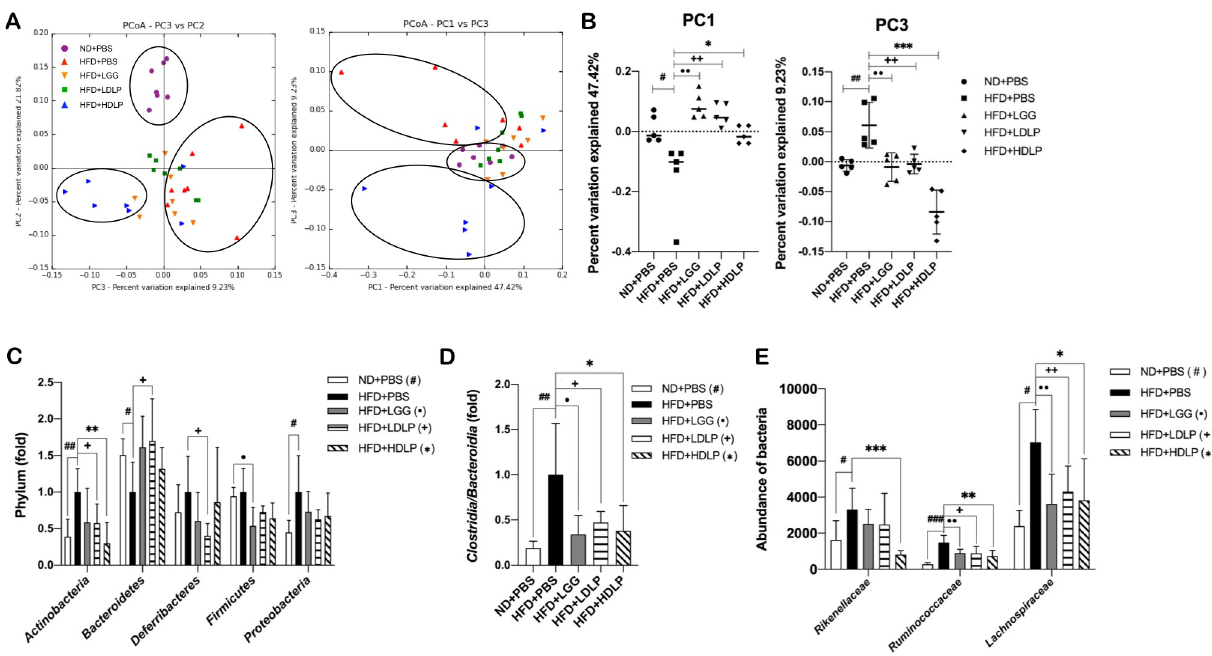
Fig 5. L . plantarum treatment modulate the gut microbial population. (A) Principal coordinated analysis (PCoA) plots generated from weighted UniFrac distance metrics (n = 7). (B) The value of PC1 and PC3 from weighted UniFrac distance metrics matrix (n = 5). Each dot represents one mouse. (C) Relative abundance of phylum level bacteria in fecal sample (n = 6–7). (D) The ratio of Clostridia to Bacteroidia classes (n = 6–7). (E) Relative abundance of family level bacteria in fecal sample (n = 6–7). Data present mean ± SD. Student’s two-tailed t-test was used for analysis of differences between groups. #, •, +, � p < 0.05, ##, ••, ++, �� p < 0.01, ###, •••, +++, ��� p < 0.001.